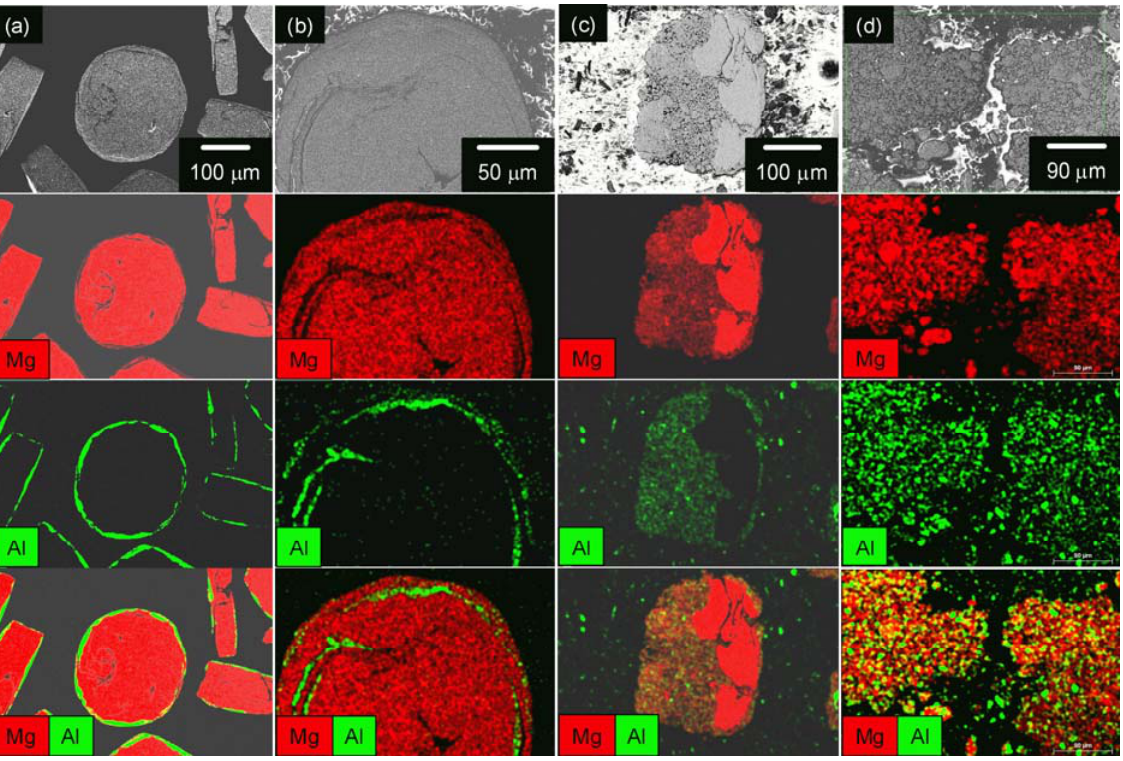
Figure 2. EDX-SEM composition maps for the Mg-7.4%Al powder milled at RT for ( a ) 5, ( b ) 40 and ( c ) 100 h, and ( d ) after RT milling for 100 h followed by 3 h of